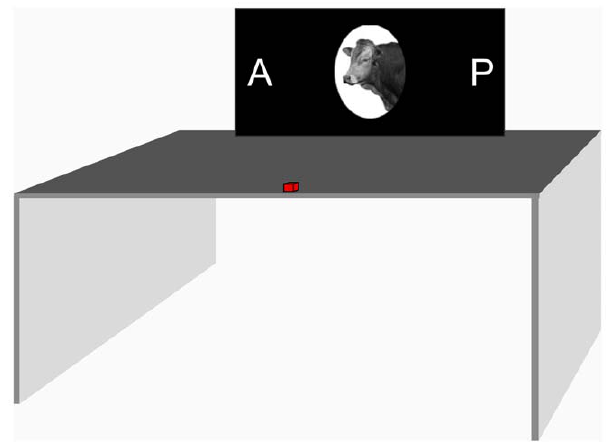
Figure 2. Experimental Apparatus. Subjects initiated trials by pressing the red button. They then responded by reaching out and touching the ‘A’ for animal targets or the ‘P’ for person targets.